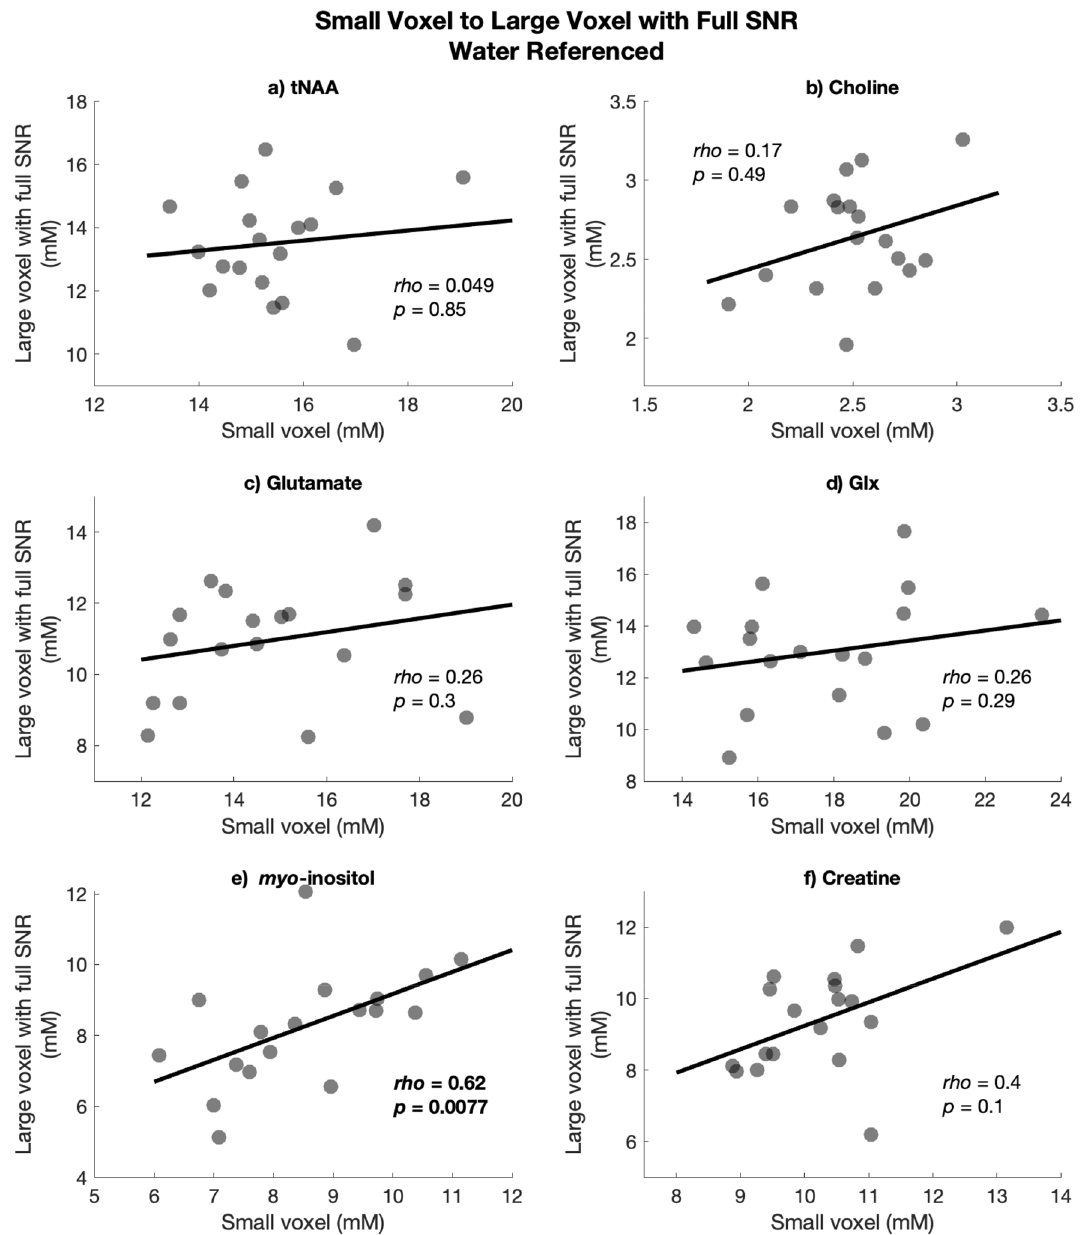
Figure 5. Spearman’s rho correlations between water-referenced (milli-molal) values in the large voxel with full SNR on the y-axis and the small voxel on the x-axis ( a ) tNAA, ( b ) Choline, ( c ) Glutamate, ( d ) Glx, ( e ) myo- inositol and ( f ) Creatine